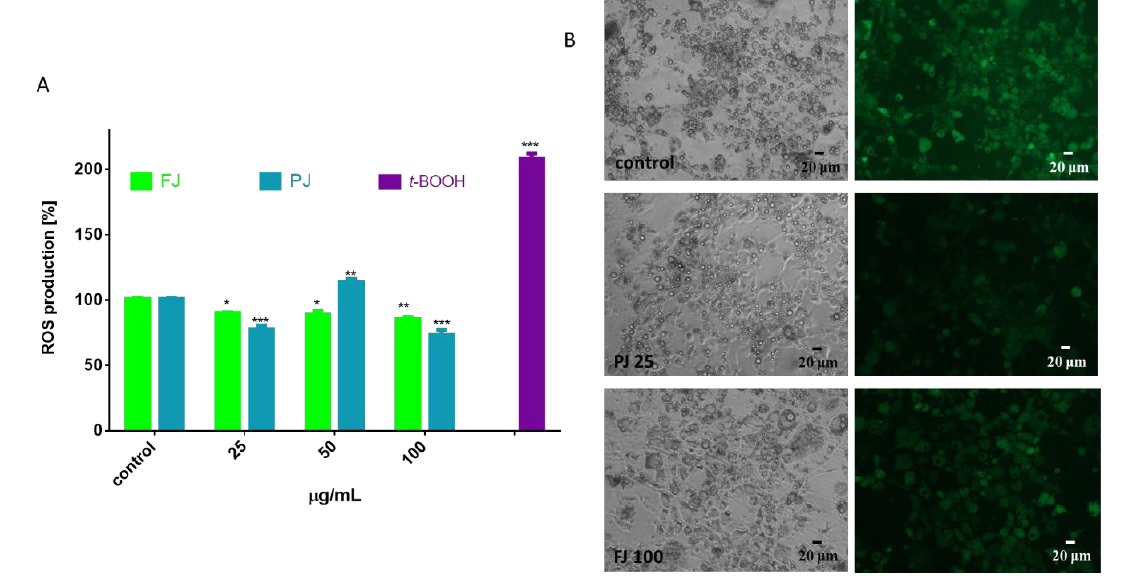
Figure 10. Influence of V. opulus FJ and PJ preparations on the intracellular reactive oxygen species generation analyzed by DCFH-DA assay in differentiated 3T3-L1 cells ( A ); control cells were not exposed to any compound; as a positive control for ROS generation, 500 µM t-BOOH was used; values are means ± standard deviations from at least three independent experiments, n ≥ 9; statistical significance was calculated versus control cells * p ≤ 0.05, ** p ≤ 0.01,*** p ≤ 0.001. Cells visualized under phase-contrast and fluorescent microscope (200× magnification) ( B ).